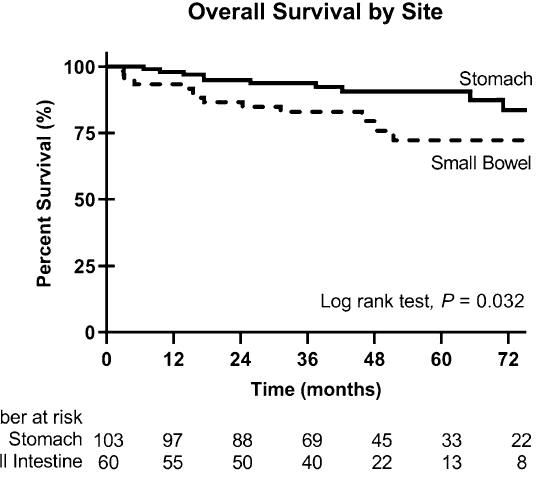
Figure 1. Kaplan–Meier curves for overall survival in gastric and small bowel WT GIST. Small bowel primary site is significantly associated with abbreviated overall survival compared to gastric